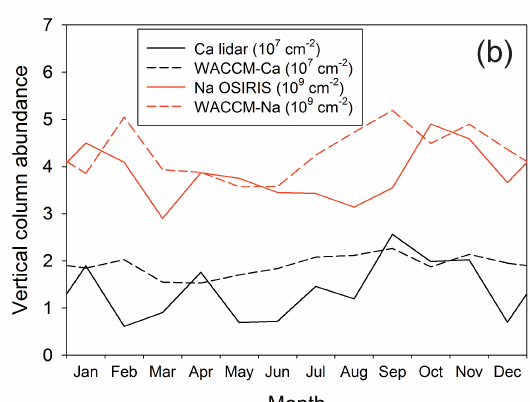
Figure 5. Annual variation of the Ca layer over Kühlungsborn (54 ◦ N): (a) lidar measurements, (b) WACCM-Ca standard model run, (c) WACCM-Ca sensitivity run where the rate coefficients for Reactions (R24) and (R25) are set to their respective Langevin cap- ture rates.